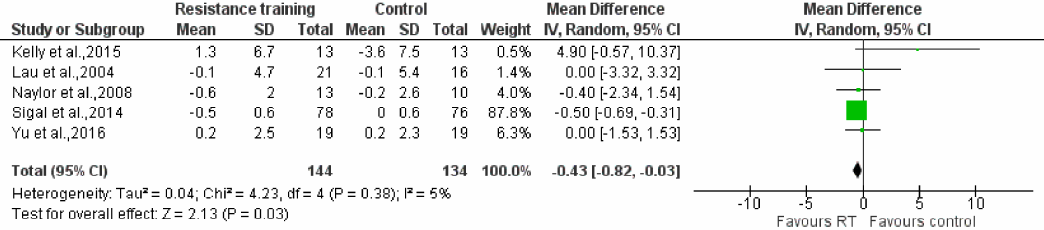
Figure 4. The e ff ect of Resistance Training on diastolic blood pressure (mmHg). Total: total number of Figure 4. The effect of Resistance Training on diastolic blood pressure (mmHg). Total: total number Figure 4. The effect of Resistance Training on diastolic blood pressure (mmHg). Total: total number Figure 4. The effect of Resistance Training on diastolic blood pressure (mmHg). Total: total number subjects; CI: confidence interval. of subjects; CI: confidence interval. of subjects; CI: confidence interval. of subjects; CI: confidence interval.